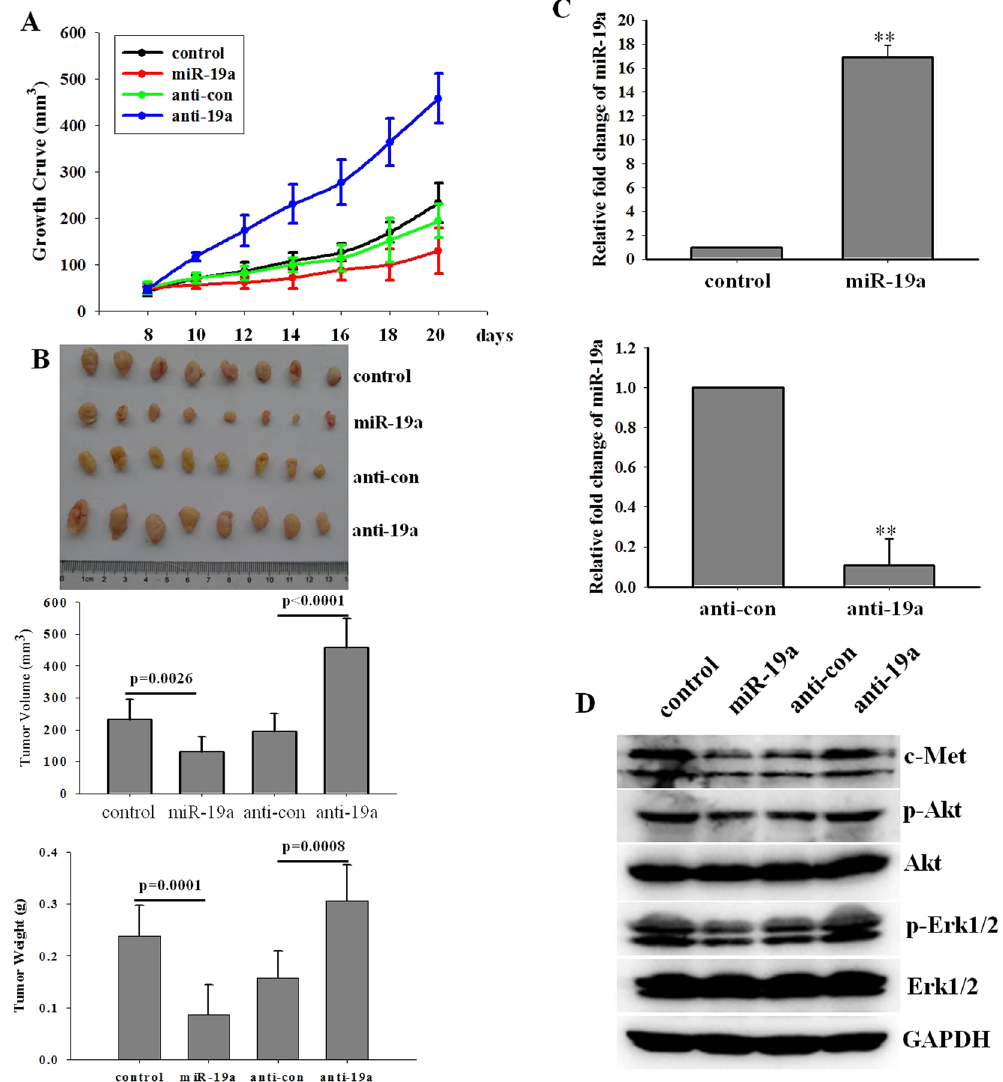
Figure 7. miR-19a overcomes gefitinib resistance in vivo . A549 cells were cultured, collected, washed and resuspended in culture medium (approximately 2 × 10 7 /ml) before being subcutaneously injected into athymic nude mice. After each tumor reached macroscopic size, gefitinib (10 mg/kg) was orally administered to each mouse every other day, and each tumor was measured. The tumor growth curves of four groups for a period of 3 weeks were generated ( A , B ). After 3 weeks, the mice were sacrificed, and the tumors were collected and measured; tumor in photograph ( B , top), mean tumor volume ( B , center), mean tumor weight ( B , bottom) (mean ± sd, n = 8) ( C ). miR-19a expression in each group was detected by qRT-PCR; the c-Met, p-Akt, p-Erk protein levels were detected with a western blot ( D